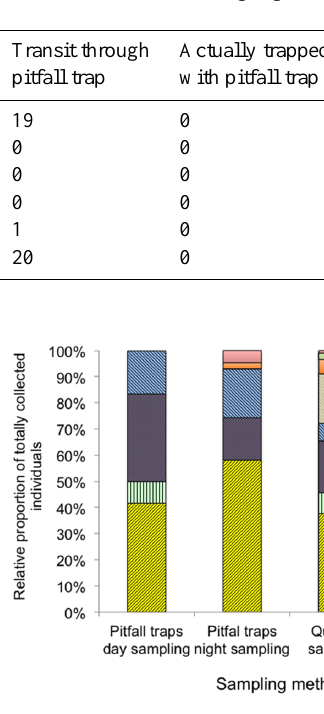
Table 2. Number of arthropods individuals in the vicinity of pitfall traps observed by video monitoring, passing through and actually collected through pitfall traps. UFO is an undetermined flying organism and UCO is an undetermined crawling organism.